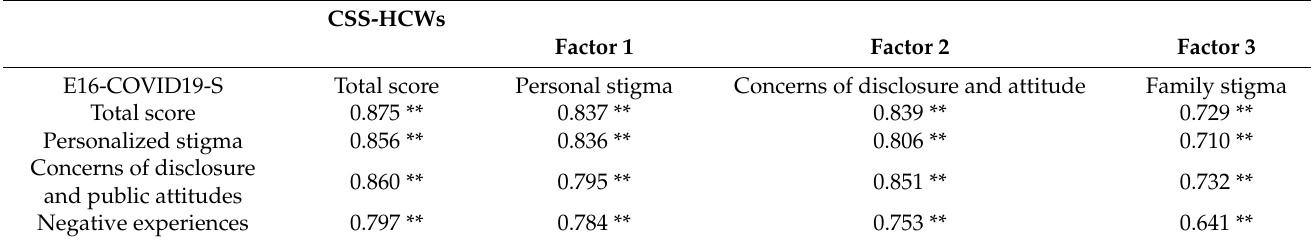
Table 3. Relationship between CSS-HCWs and E16-COVID19-S ( n =